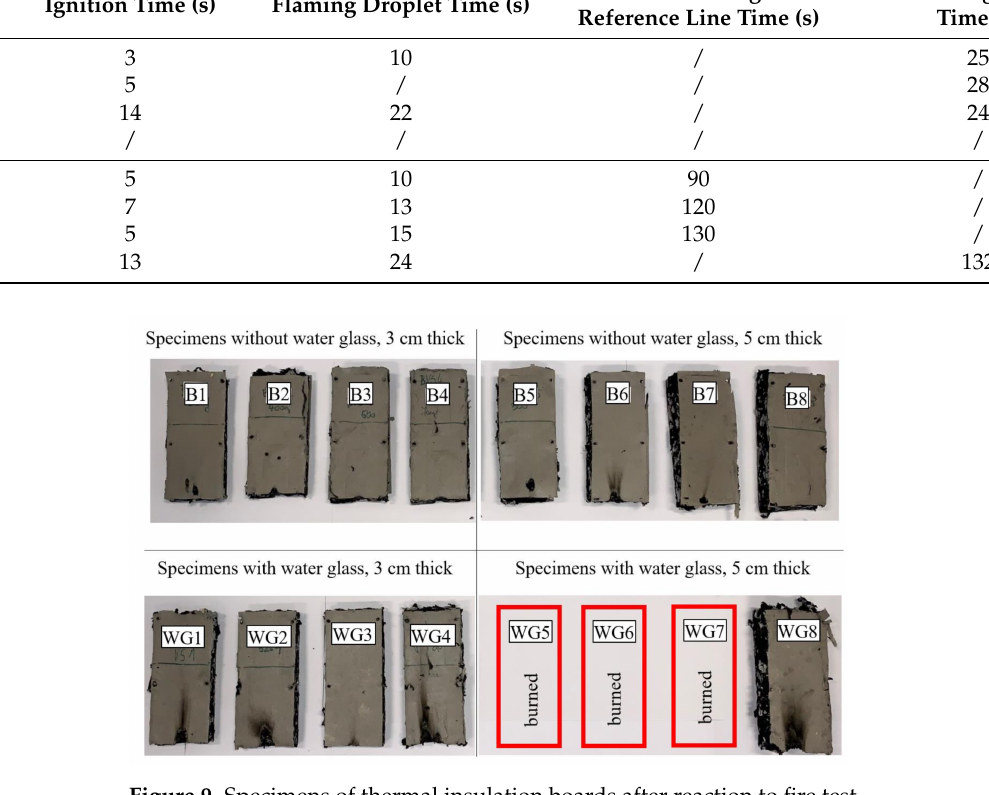
Figure 9. Specimens of thermal insulation boards after reaction to fire